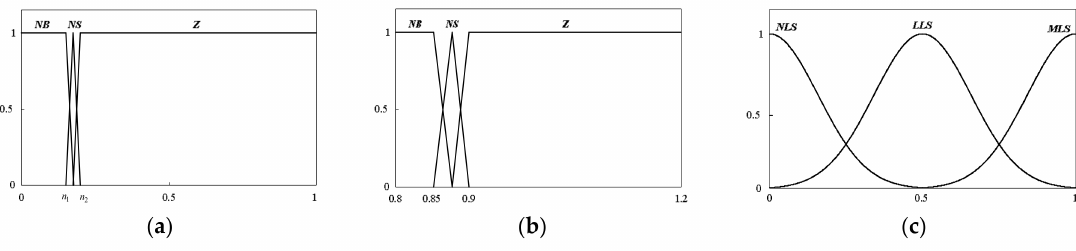
Figure 5. The membership functions. ( a ) Fuzzy input variable ILM ; ( b ) Fuzzy input variable V ; ( c ) Fuzzy output variable LS